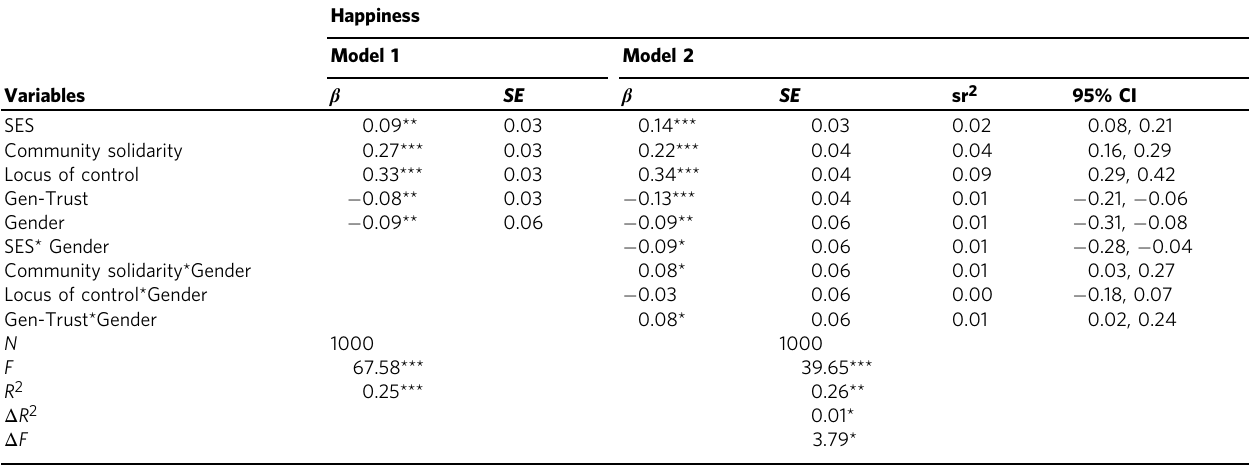
Table 3 Hierarchical regression model of SES and social capital variables as predictors of happiness with gender as a